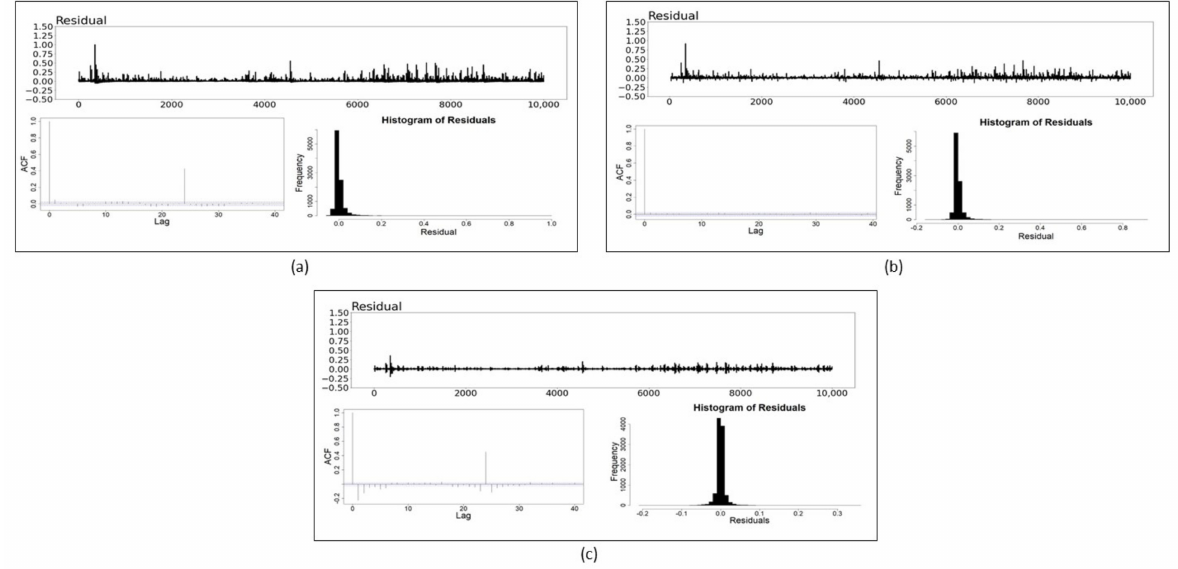
Figure 6. Residual plots, ACF plots and histograms of the: ( a ) GARCH (1,1) model; ( b ) NN model and ( c ) SS model for Litecoin. The blue dotted lines in ACF plots indicate the point of statistical